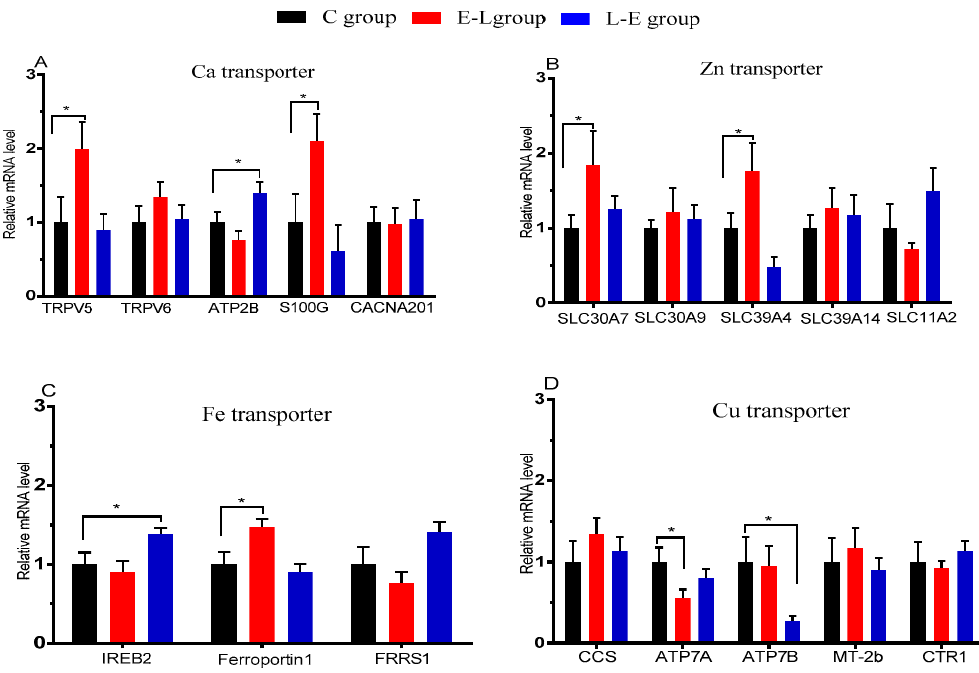
Figure 2. mRNA expression of Ca, Cu, Fe, and Zn transporters in the placenta of sows; n = 9. Statistical significances were set at * p < 0.05.